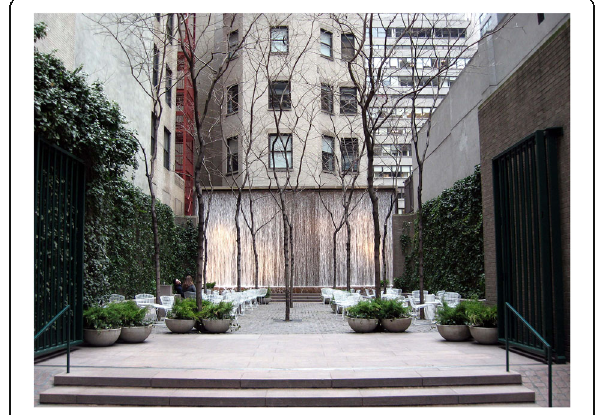
Fig. 5 Paley Park, New York, by Zion and Breen in 1967. [Credit Jim Henderson, and reprinted under Creative Commons